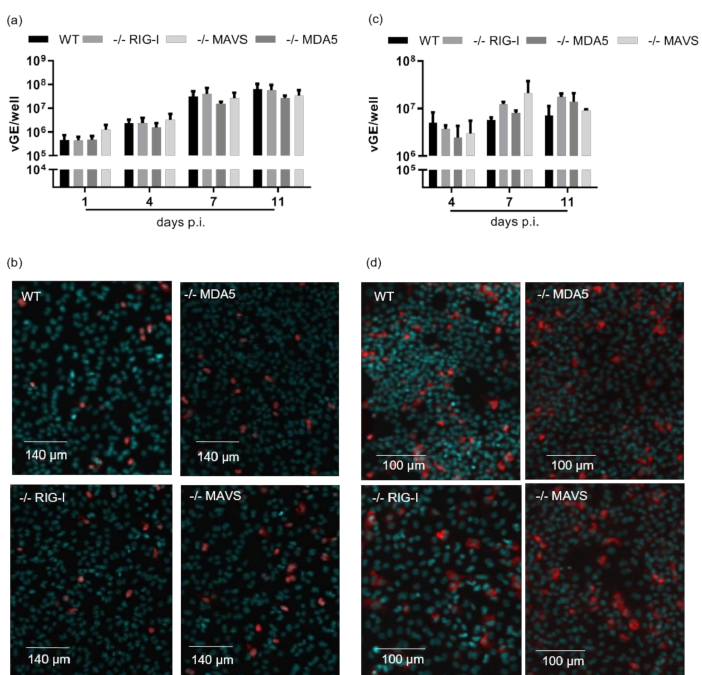
Figure 3. Intracellular pattern recognition of HDV does not impair virus replication. RIG-I, MAVS and MDA5 knockout-HepG2-NTCP cells were seeded in a 24-well plate, infected with HDV at an MOI of 20 vp/cell ( a , b ) or transduced with AAV-HDV at an MOI of 10 4 vp/cell ( c , d ). ( a ) Absolute numbers of vGE/well detected in infected cells by qRT-PCR. Bars represent one single experiment with biological triplicates. ( b ) Exemplary HDAg immunofluorescence staining 11 dpi. Scale bars 140 µ m. ( c ) Absolute numbers of vGE/well detected in infected cells by qRT-PCR. Bars represent one single experiment with biological triplicates. ( d ) Exemplary HDAg immunofluorescence staining 12 dpi. Scale bars 100 µ